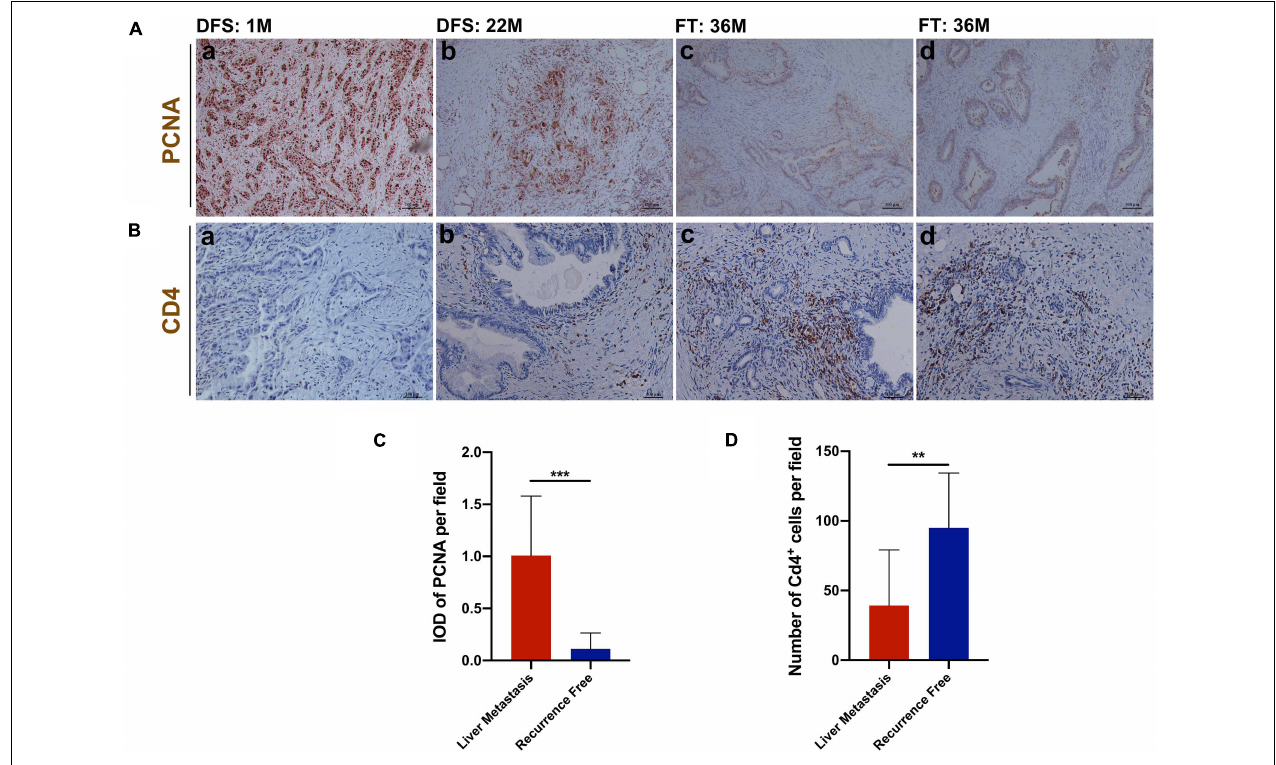
FIGURE 9 | Immunohistochemical analysis of tumor proliferation and CD4 + T cells infiltration. (A) (a,b) Proliferative activity of tumor cells decreased with the prolongation of liver metastasis; (c,d) Proliferative activity of tumor cells was almost undetectable in recurrence-free patients. (C) Patients with early postoperative liver metastasis of pancreatic cancer had higher proliferative activity. (B,D) Patients with early postoperative liver metastasis had fewer CD4 + T cells infiltration. ** P < 0.01, *** P < 0.001.